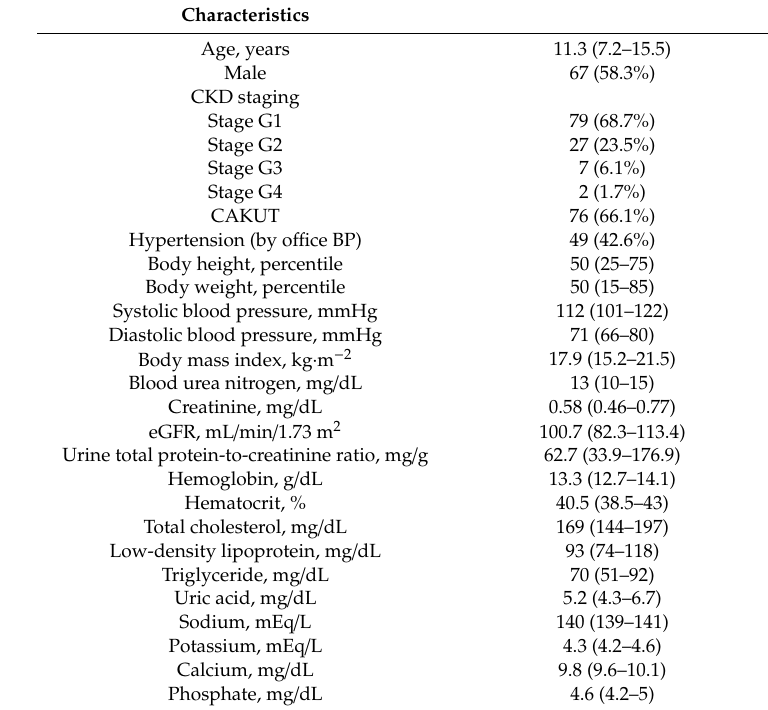
Table 1. Descriptive statistics for clinical, anthropometric, and biomedical characteristics of 115 study